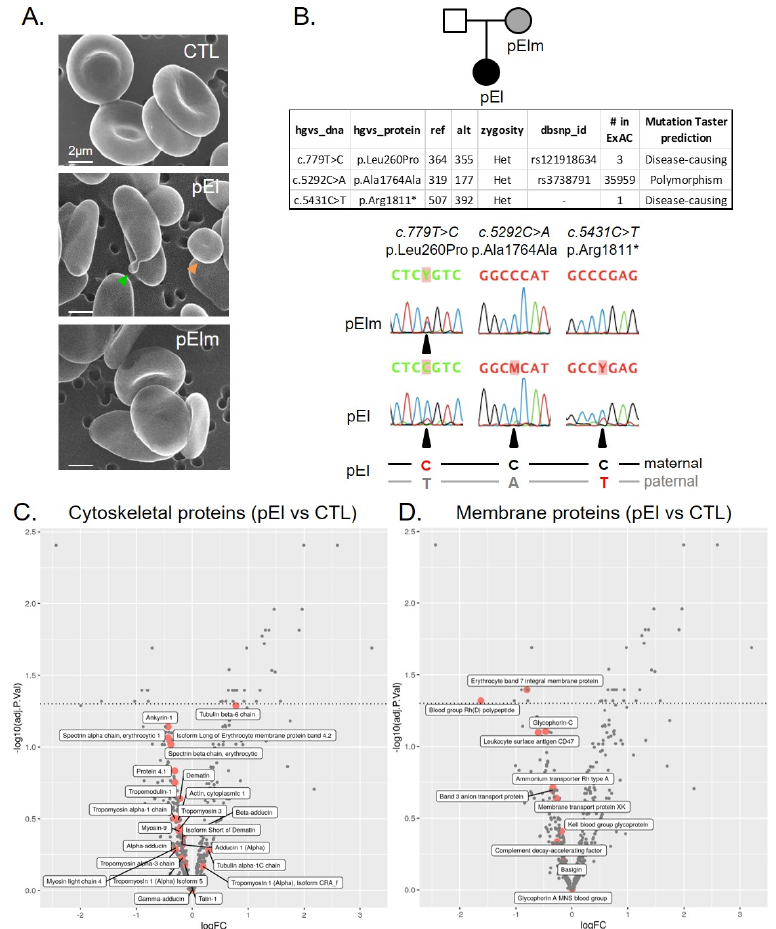
Figure 1. Patient pEl expressed predominantly the Pro260 variant of SPTA1 and exhibited RBCs with an elliptic shape but a globally preserved cytoskeletal and membrane protein content. ( A ) RBC morphology evaluated on RBCs fixed in suspension, laid down on filters and analyzed by scanning electron microscopy. Images are representative of 2 independent experiments. Orange arrowhead, small spherical RBC; green arrowhead, poïkilocytotic RBC. ( B ) Pedigree and genetic defects in patient pEl. pElm was partially a ff ected but not diagnosed. Table. NGS results for patient pEl showing coverage (ref, reads with reference allele; alt; alternative allele), zygosity, code in dbSNP, number of occurrences in control population (The Exome Aggregation Consortium) and impact prediction from Mutation Taster, for two likely mutations and one heterozygous polymorphism in SPTA1 . Sequences. mRNA sequencing showing partial loss of the allele carrying the premature Stop codon (T-allele at position 5431) in patient pEl. Maternal pElm is heterozygous for Leu260 Pro, whereas patient pEl is almost homozygous for the C at position 779 (Proline) and at position 5292, due to degradation. Y = T or C; M = C or A. ( C , D ) Cytoskeletal ( C ) and membrane ( D ) protein contents evaluated by di ff erential quantitative mass spectrometry on ghost membranes. Volcanoplots show the log 2 fold changes (logFC) in patient pEl vs. A healthy donor from 3 independent ghost preparations. Proteins showing a negative or a positive logFC are decreased or increased in patient pEl vs. The healthy donor, respectively. Proteins above the dotted line show a significant di ff erence ( p < 0.05) in patient pEl as compared to the healthy